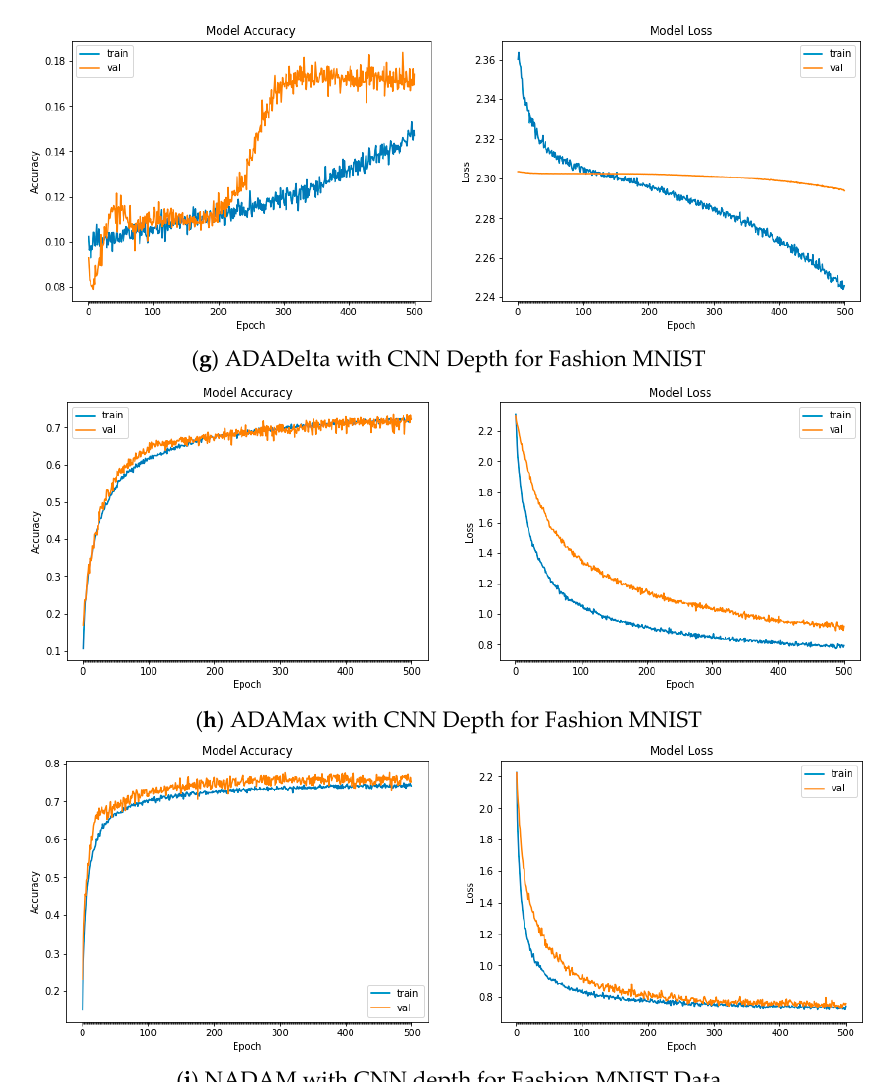
Figure A3. Plots of Train and Validation Test accuracies and losses of the CNN model with varying depth for Fashion MNIST: ( a ) Vanilla SGD; ( b ) SGD momentum; ( c ) SGD Nesterov momentum; ( d ) ADAGrad; ( e ) RSMProp; ( f ) ADAM; ( g ) ADADelta; ( h ) ADAMax; ( i ) NADAM.